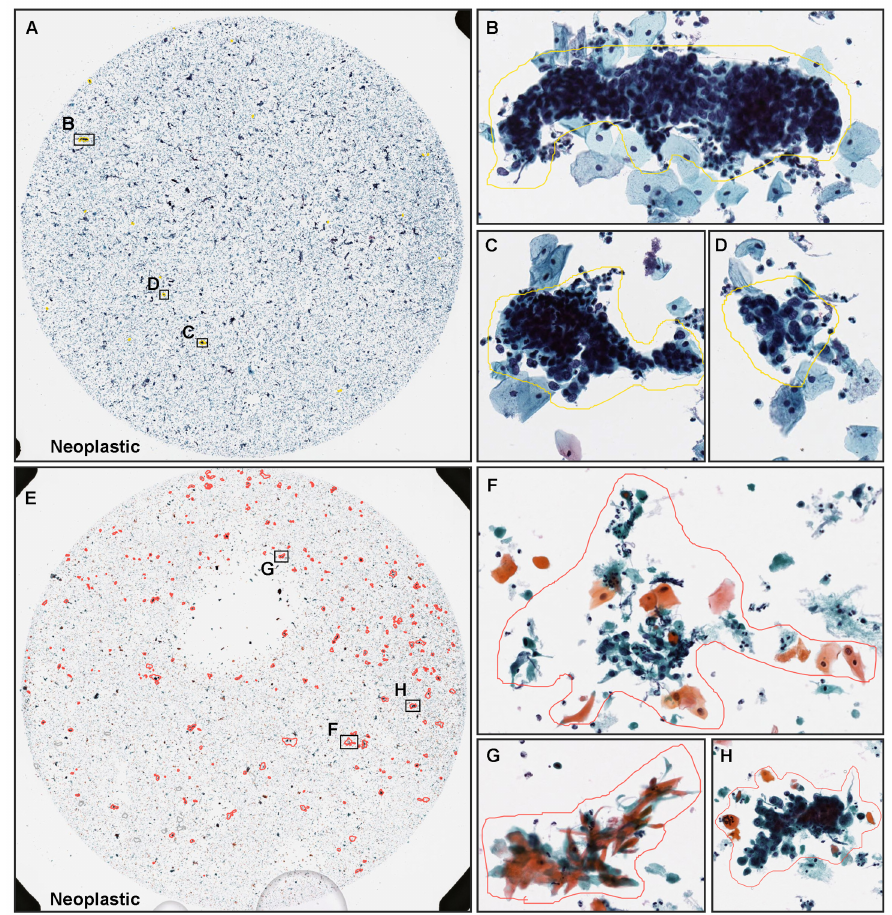
Figure 1. Representative manually drawing annotation images for neoplastic labels on liquid- based cytology (LBC) slides. The LBC case ( A ) was diagnosed as HSIL (high-grade squamous intraepithelial lesion) based on the representative neoplastic squamous epithelial cells with increase in nuclear/cytoplasmic ratio and nuclear atypia ( B – D ). The LBC case ( E ) was diagnosed as SCC (squamous cell carcinoma) based on the representative neoplastic squamous epithelial cells with HSIL features ( F – H ). Representative neoplastic cells were roughly annotated using in-house on-line drawing